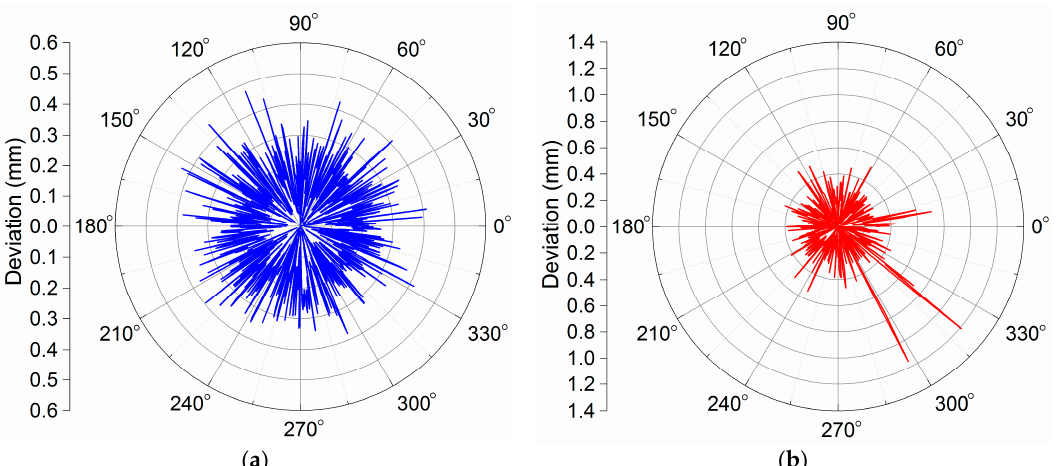
Figure 37. Deviation results of target planning path and actual tool path of experimental deburring for proximal side facet (polar representation): ( a ) facet edges deburring deviation; ( b ) orifice edges deburring deviation.